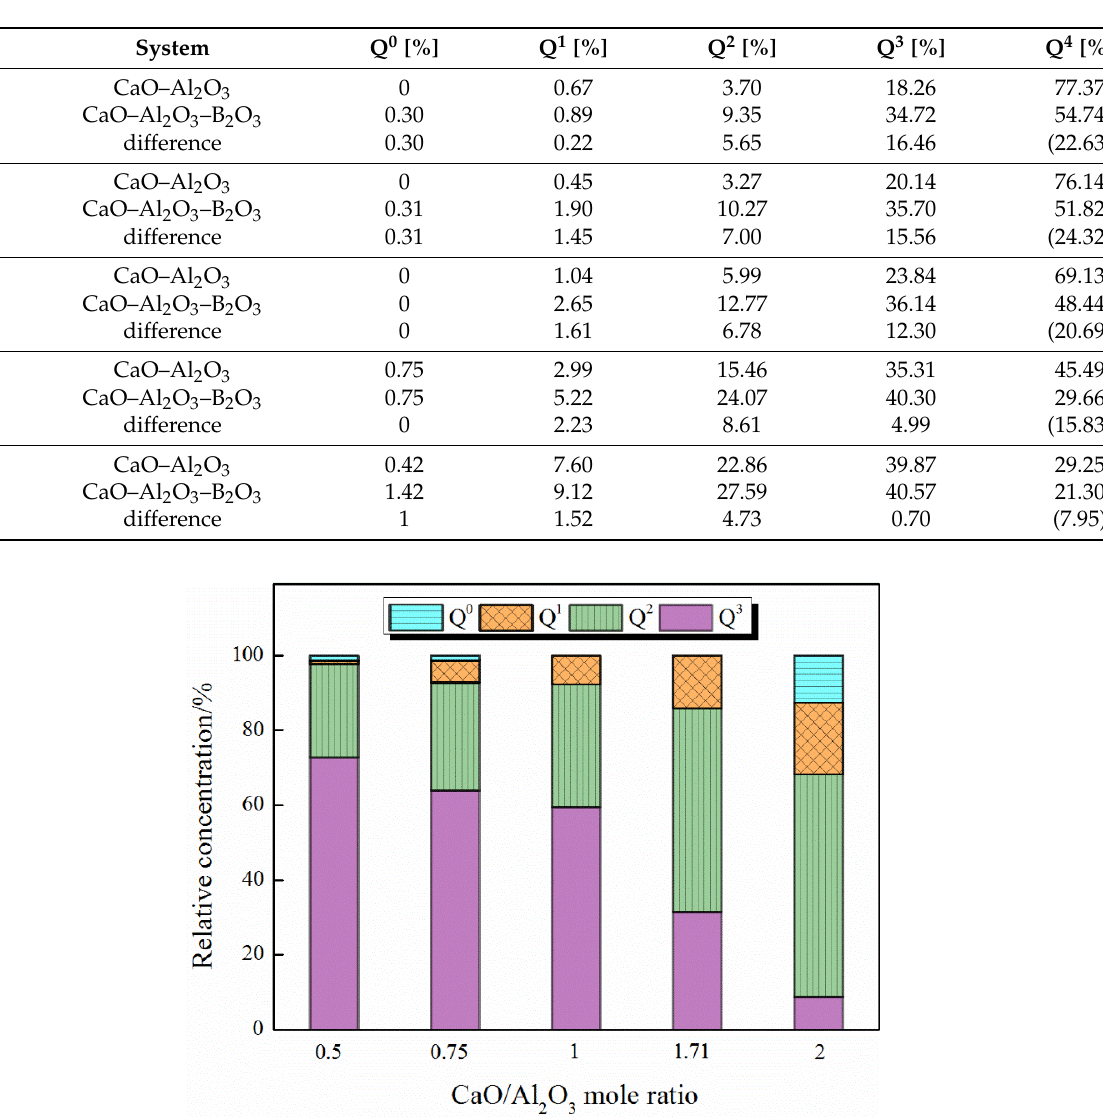
Table 6. The effect of the addition of B 2 O 3 on the aluminate network under different CaO/Al 2 O 3 mole ratios.